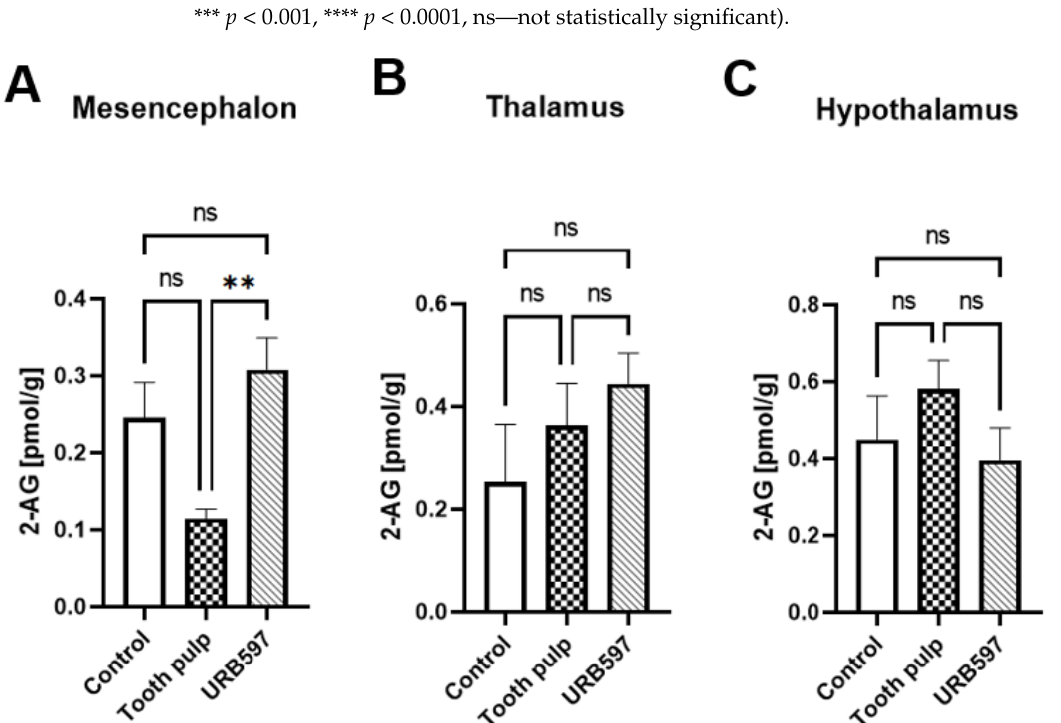
Figure 7. Quantitative RT-PCR analysis of MOR mRNA expression in ( A ) mesencephalon, ( B ) thal- amus and ( C ) hypothalamus induced by tooth pulp and URB597 treatment. The data represent mean ± SEM of 6 rats per group. Statistical significance was assessed using one-way ANOVA and a post hoc multiple comparison Tukey test. Asterisks denote significance level (* p < 0.05, ** p < 0.01, *** p < 0.001, **** p < 0.0001, ns — not statistically significant).